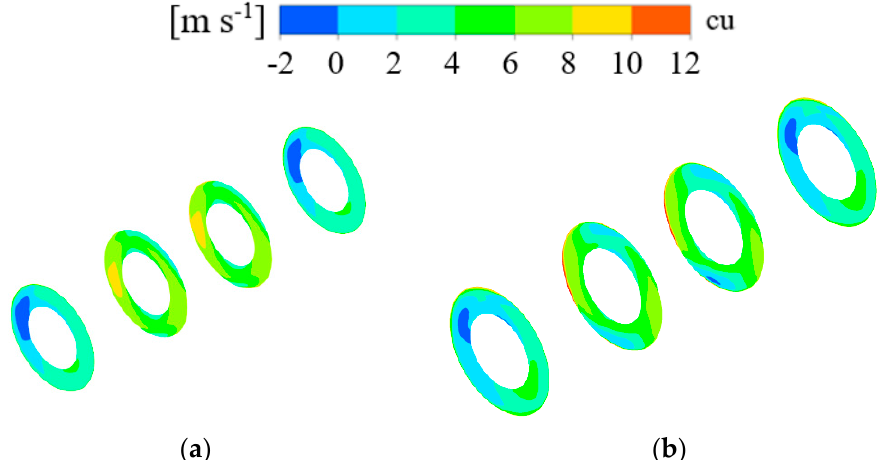
Figure 9. Comparison of the peripheral speed distribution of the impeller inlet before ( a ) and after ( b ) optimization.